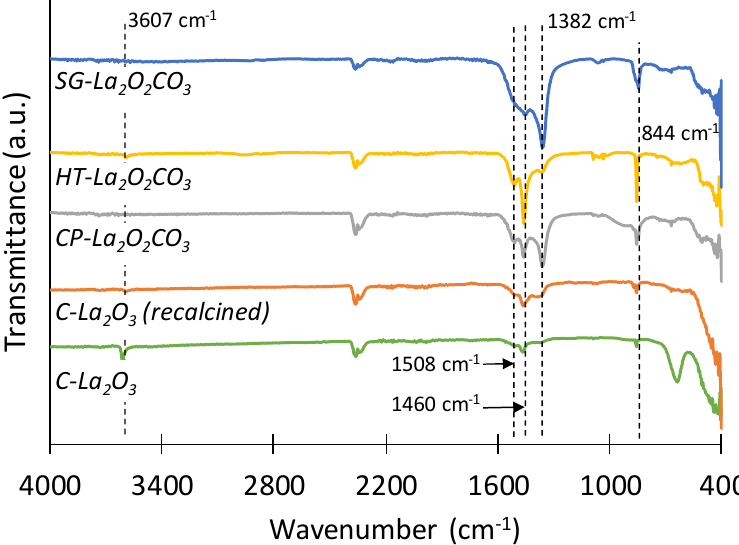
Figure 3. FTIR spectra of C-La 2 O 3 and calcined C-La 2 O 3 and La 2 O 2 CO 3 catalysts prepared via co-precipitation (CP), sol-gel (SG) and hydrothermal (HT) methods.